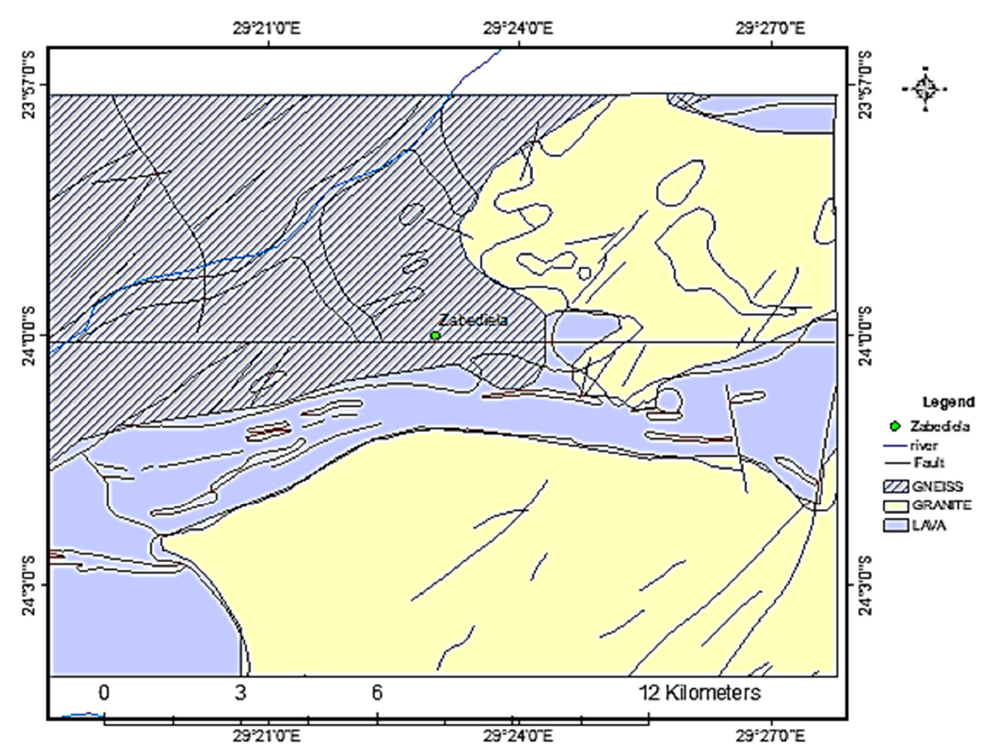
Figure 2. Geological setting of Zebediela kaolin occurrence. Modified from [18].